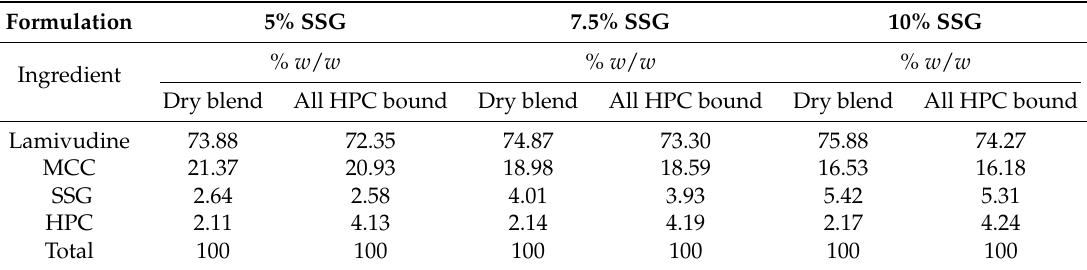
Table 2. Intra-granular blend components’ compositions.